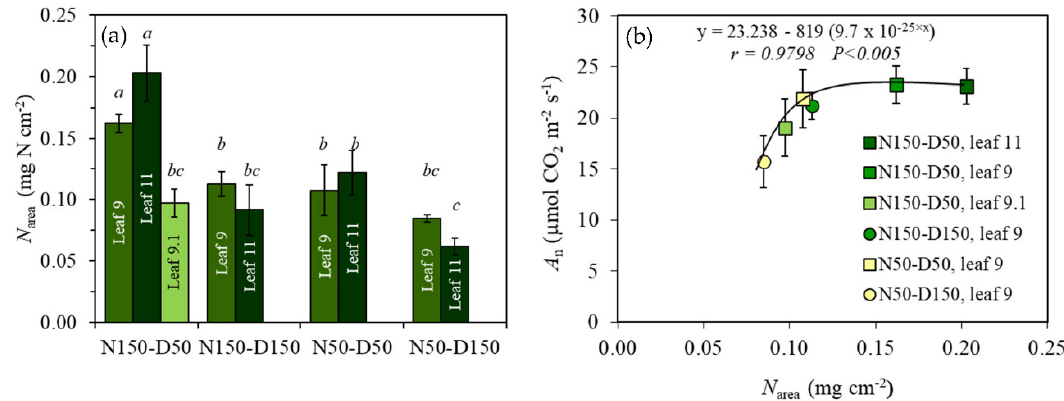
Figure 3. ( a ) Leaf N content per area ( N area ) of leaves at different phytomer ranks in response to N supply and plant density. ( b ) Light-saturated photosynthesis ( A n ) ( I inc = 1500 µmol·m − 2 ·s − 1 ; CO 2 = 390 µmol·mol − 1 ) in relation to N area at 7 days before flowering (BBCH 62). Different letters indicate significant differences across treatments ( p < 0.05), and vertical bars indicate the standard error of means.